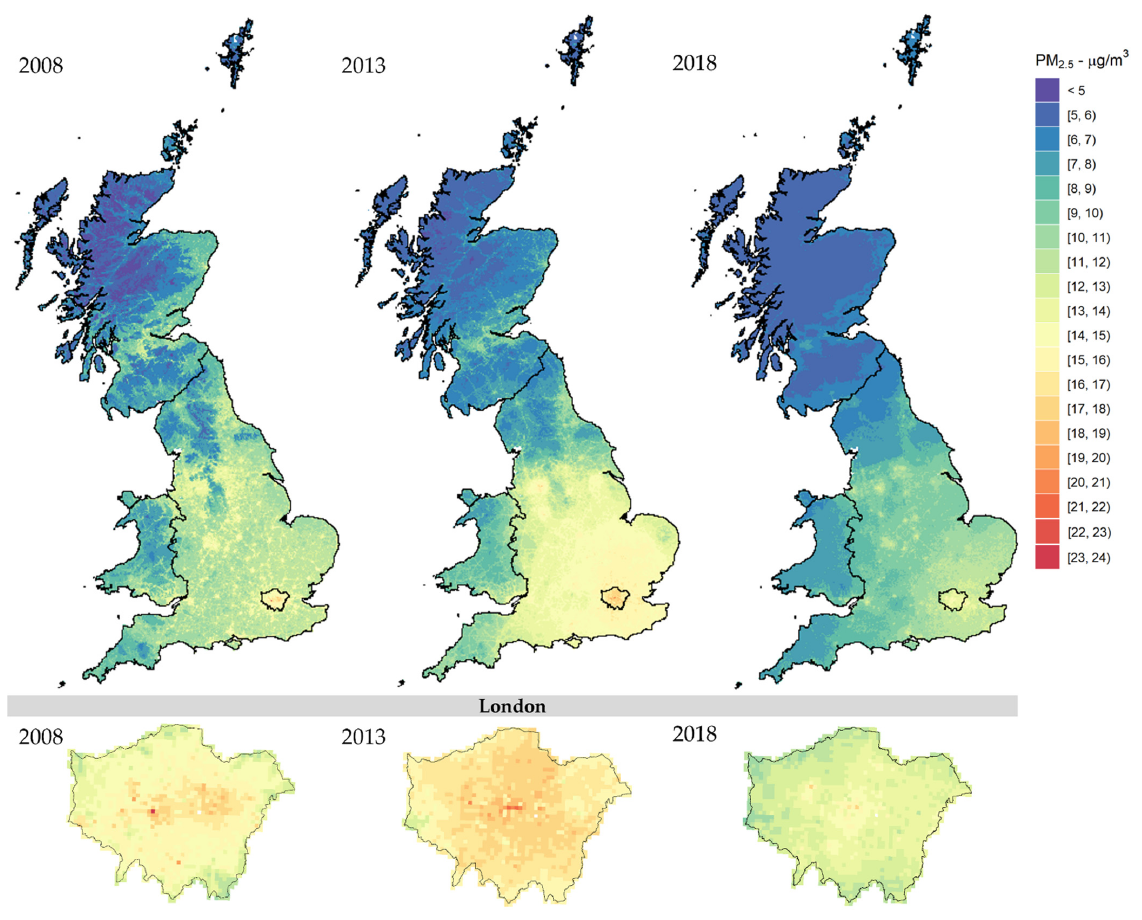
Figure 3. Stage-4 predicted PM 2.5 concentrations across Great Britain ( Top ) and London ( Bottom ) for 2008, 2013, and 2018 aggregated by annual means. All plots were built under the same colour scale.